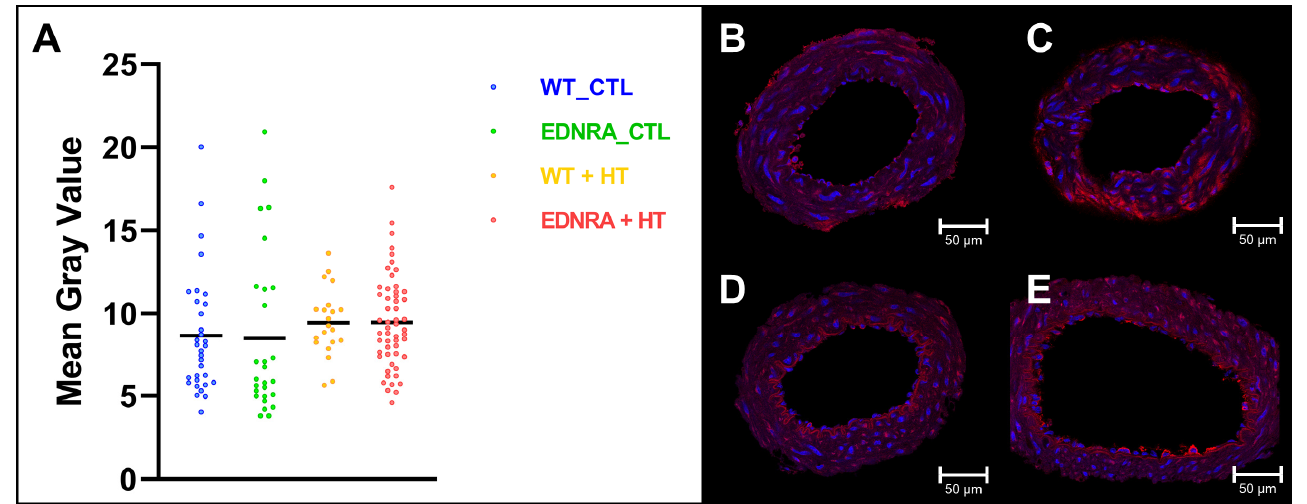
Figure 5. ( A ) Individual data points and means (black bars) of mean gray value of EDNRA in immunofluorescence after observation period of 12 weeks. Both CTL and HT groups showed similar levels of fluorescence intensity as reflection of EDRNA abundance. Despite tendency to higher levels after HT induction, none of the groups significantly differed. Therefore, EDNRA abundance seemed not to be higher after HT induction, neither in WT rats nor EDNRA rats. ( B – E ) One exemplary ring segment of BA of each group showing EDNRA immunoreactivity (red) and nuclei (blue): ( B ): WT_CTL; ( C ): EDNRA_CTL; ( D ): WT + HT; and ( E ): EDNRA +